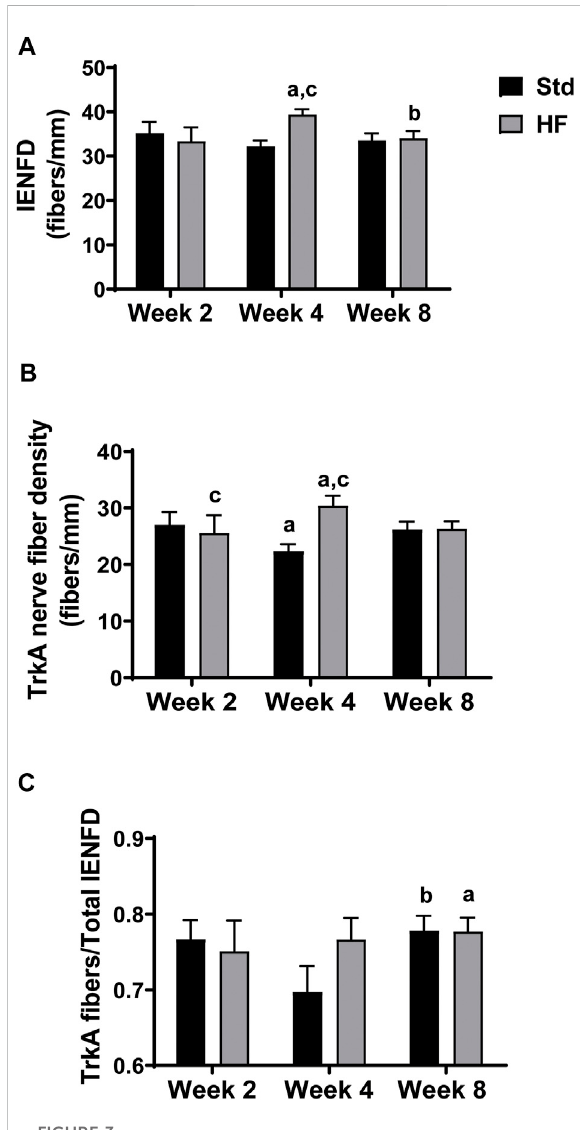
FIGURE 3 Epidermal Innervation. Intraepidermal nerve fi ber density (IENFD) includes all PGP 9.5 positive fi bers that cross the epidermal-dermal border (A) , TrkA nerve fi ber density includes all TrkA positive fi bers that cross the epidermal-dermal border (B) , and TrkA: IENFD ratio (C) . IENFD and TrkA nerve fi bers peak and are greater than Std after 4 weeks of HF feeding. a p < 0.05 vs wk 2 within diet, b p < 0.05 vs wk 4 within diet, and c p < 0.05 for Std vs HF within the week. Data are presented as mean ± SEM ( n = 8 – 12 mice per